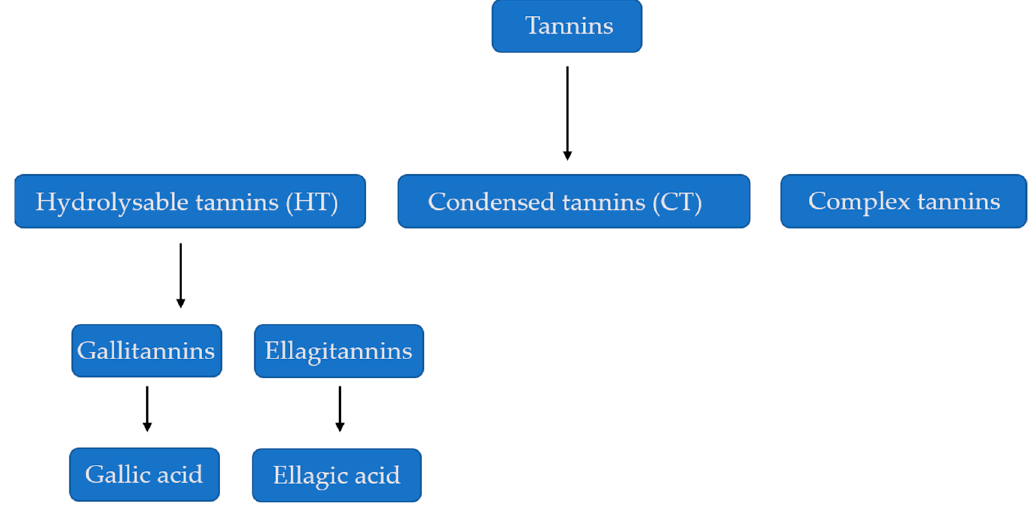
Figure 1. Classification of Tannins. Sources: [18,19].